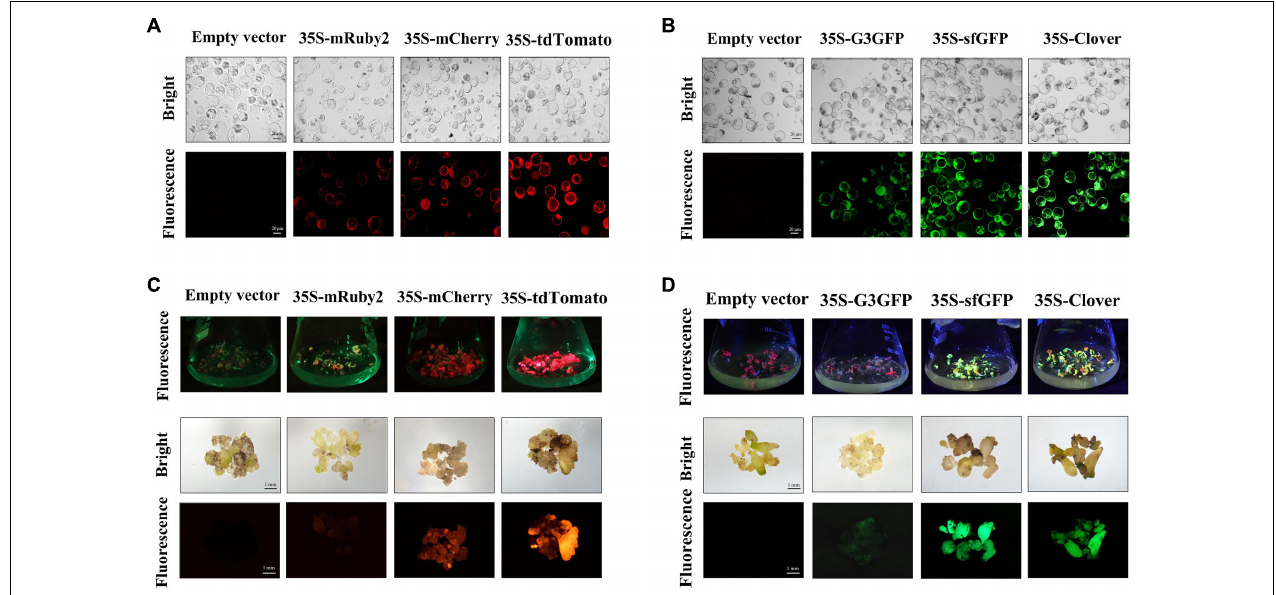
FIGURE 1 | Stable expression of red and green fluorescent proteins (RFPs and GFPs, respectively) in cotton callus and embryo tissues. The protoplast of transgenic callus expression empty vector, RFP (A) and GFP (B) under white light (bright) and excitation light (fluorescence); scale bar, 20 µ m. The transgenic embryo expression empty vector, RFP (C) , and GFP (D) under white light (bright) and excitation light (fluorescence); scale bar, 1 mm. RFPs: mRuby2, mCherry and tdTomato; GFPs: G3GFP, sfGFP and